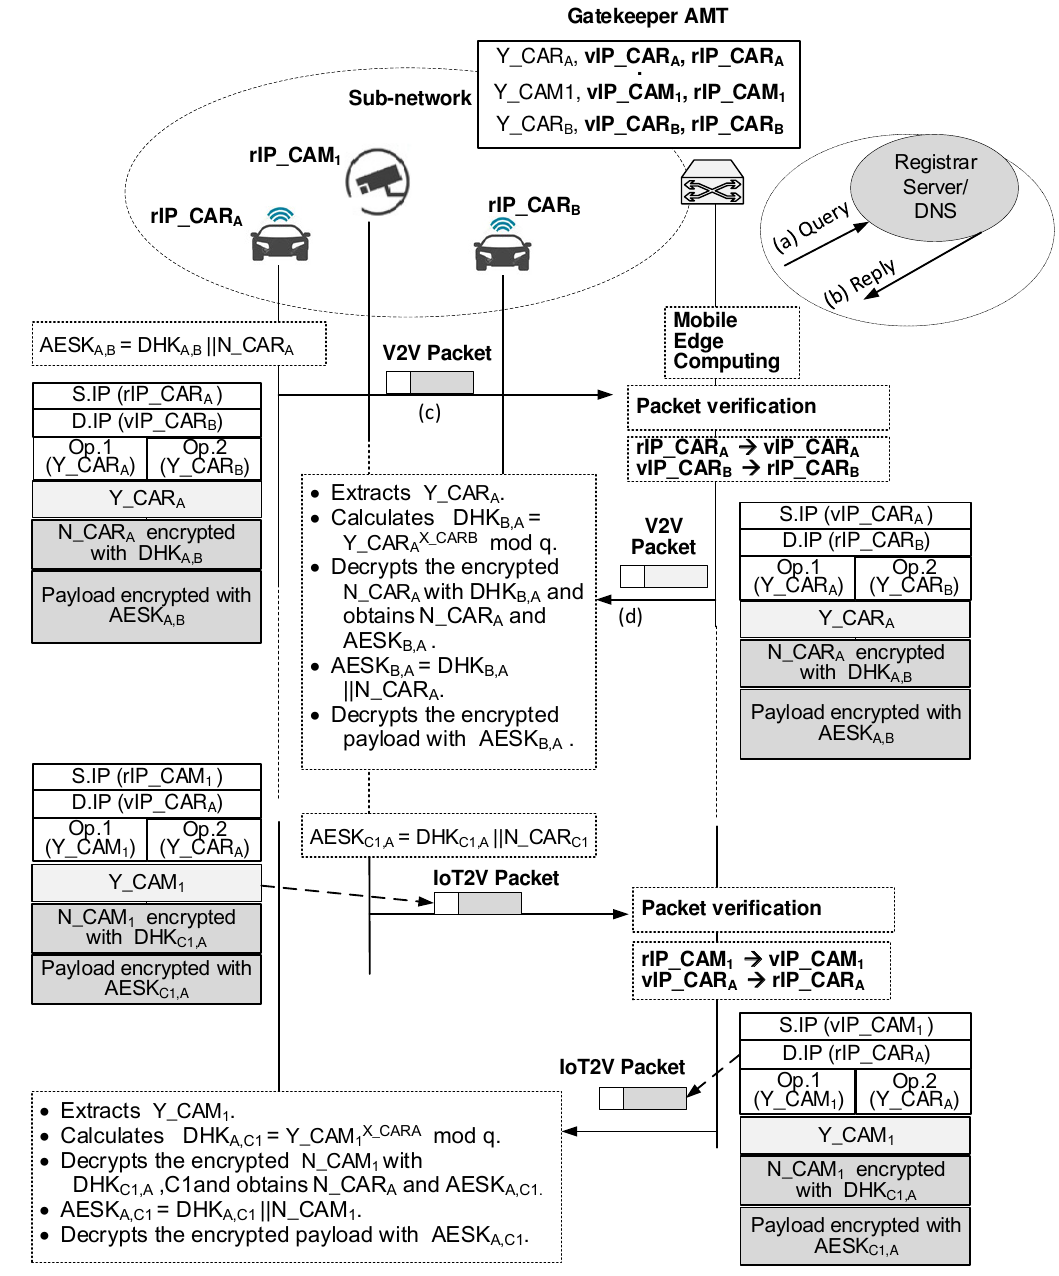
Figure 7. Gatekeeper-centric V2V and IoT2V